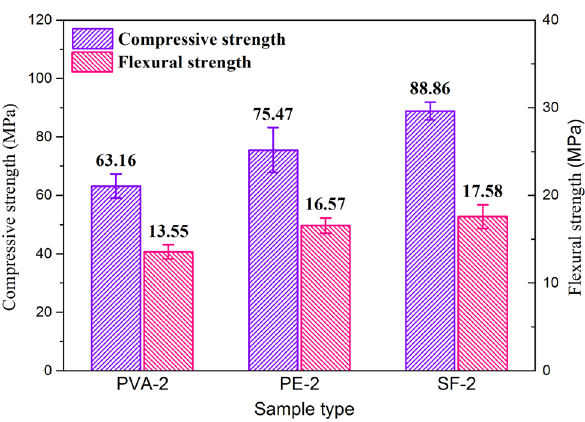
Figure 9: The fl exural stress – de fl ection behavior of lightweight cement - based composites: ( a ) PVA - 2 [ 20 ] , ( b ) PE - 2, and ( c ) SF -